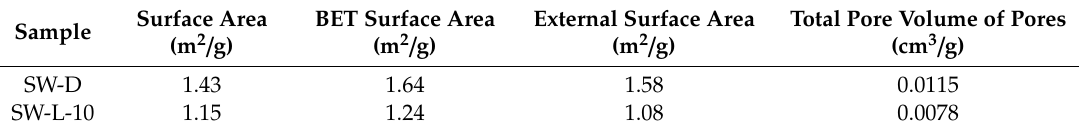
Figure 3. Pore diameter distributions of SW-D and SW-L-10. Table 2. Surface area and pore volume distribution (SW-D and SW-L-10).